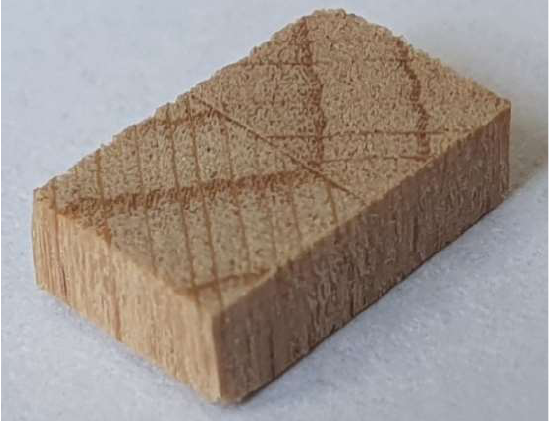
Figure 2. Prepared samples for the computer tomography.